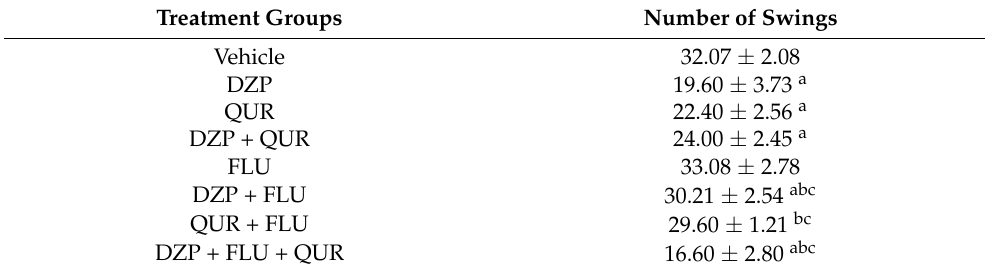
Table 3. Effects of test sample and controls in Swiss mice (swing test).